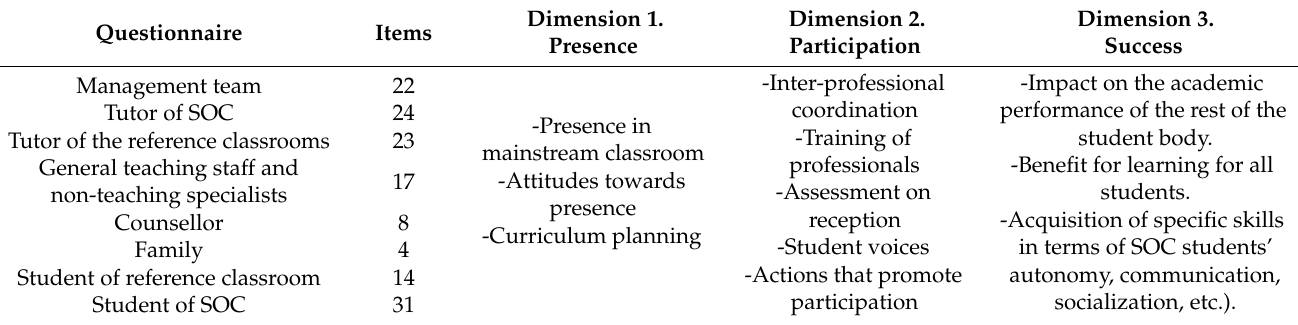
Table 2. Grouping of the items of the questionnaires by